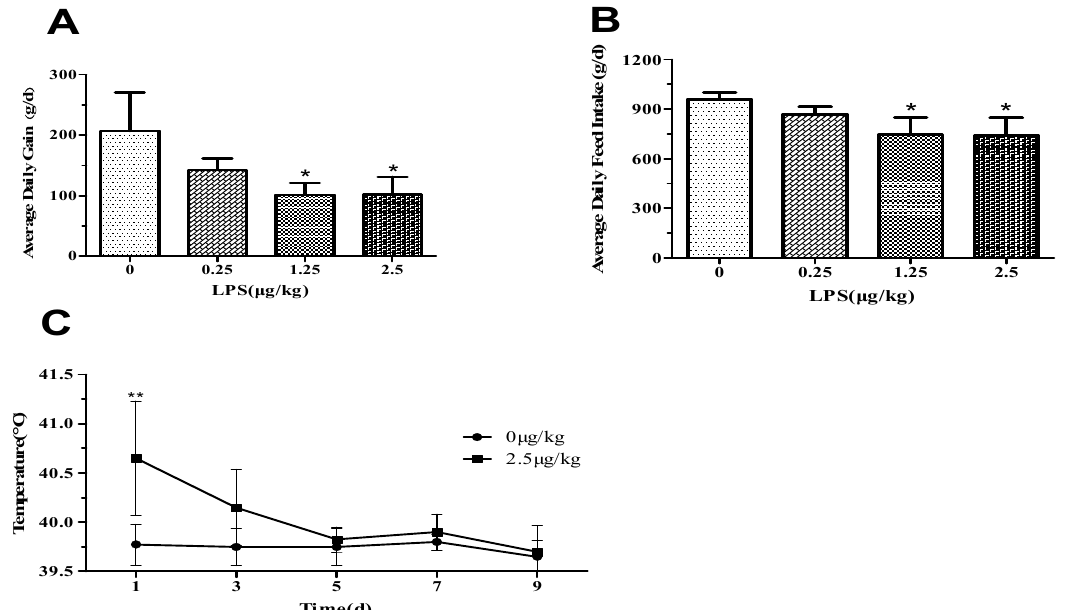
Figure 1. E ff ect of 2.5 µ g / kg body weight lipopolysaccharides (LPS) on ( A ) average daily gain, ( B ) average daily feed intake and ( C ) rectal temperature in lambs. Values are expressed as means ± SD. * p < 0.05, ** p < 0.01, and *** p < 0.001, compared with the control group.